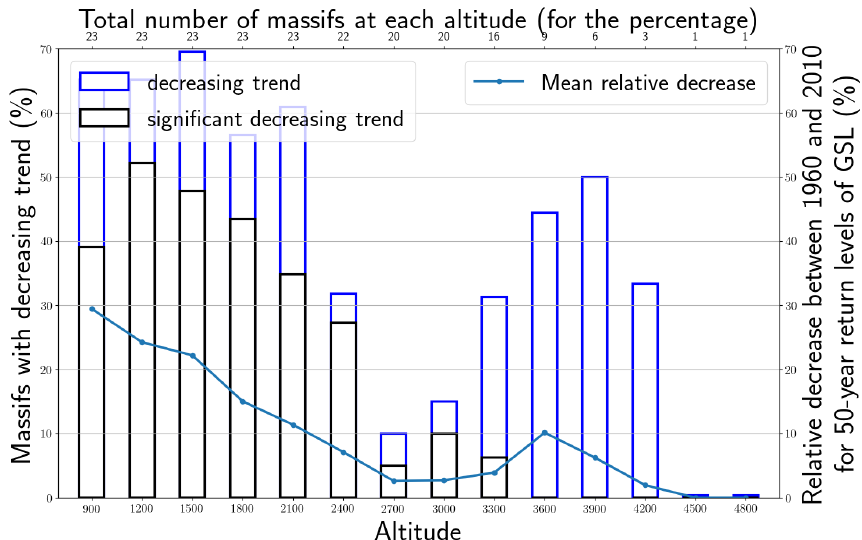
Figure 6. Temporal decreasing trend of 50-year return levels of ground snow load (GSL) between 900 and 4800m of